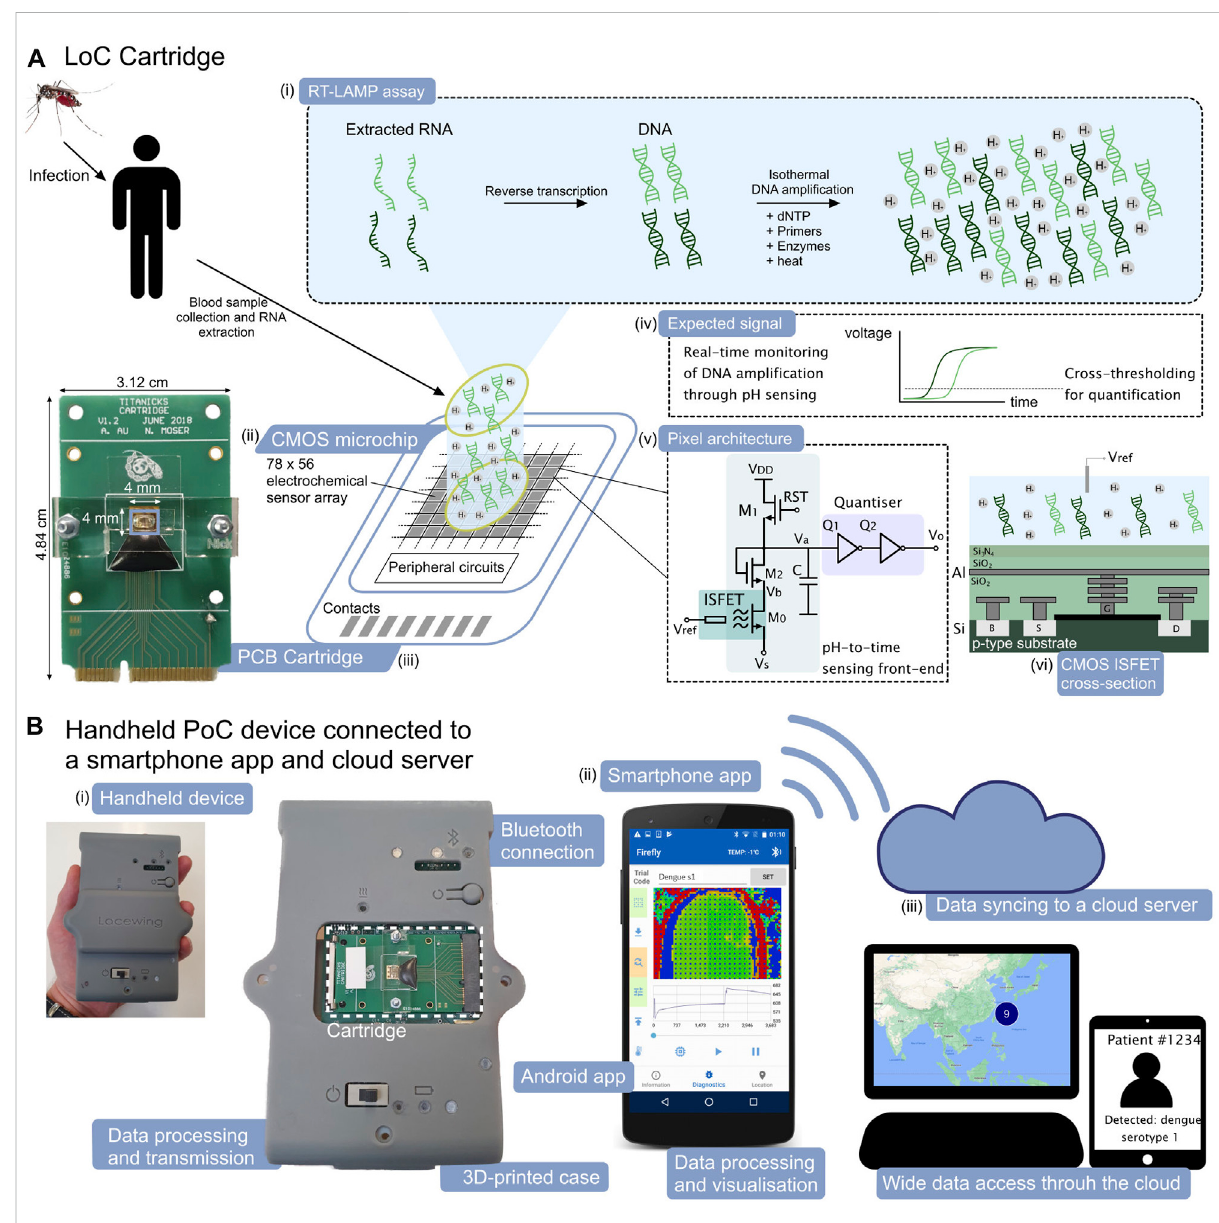
FIGURE 1 ISFET-based LoC platform and smartphone application for dengue molecular diagnostics. (A). LoC cartridge for nucleic acid ampli fi cation and detection on-chip. (i) Schematic representation of the RT-LAMP assay, (ii) Schematic view of the CMOS microchip with 78 × 56 integrated electrochemical sensors, (iii) Picture of the PCB cartridge with microchip encapsulated using epoxy and acrylic manifold, (iv) Expected form of the electrochemicalsignalassociatedwiththenucleicacidampli fi cation,(v)CMOSpixelarchitecturewithtimeencodingofthesignaland(vi)cross section of the ISFET sensor in unmodi fi ed CMOS technology. (B). Handheld PoC “ Lacewing ” device and back-end smartphone interface. (i) Photographic view of the handheld device for data processing and transmission via Bluetooth, (ii) Layout of the smartphone app and (iii) Concept view of the data syncinc to the cloud server and data